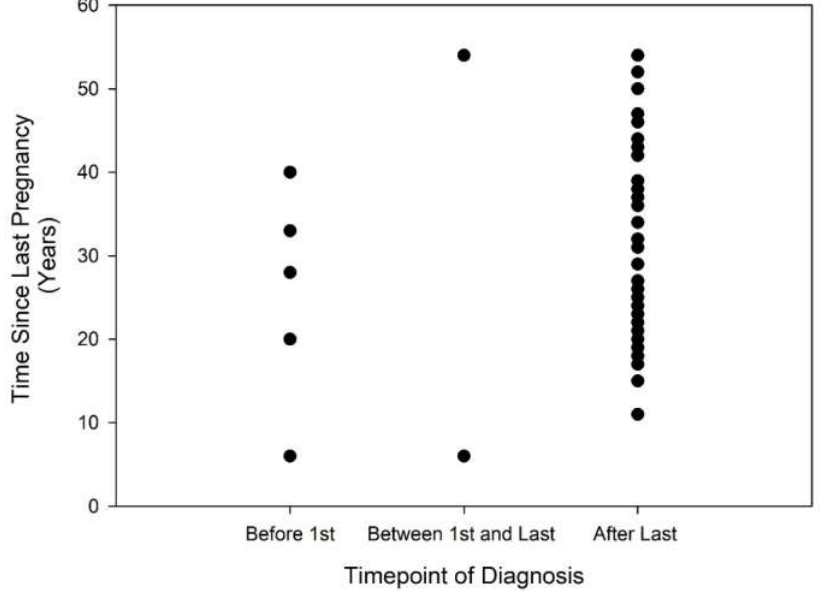
Figure 2. Time since last pregnancy (years) as a function of the timepoint of HHT diagnosis.